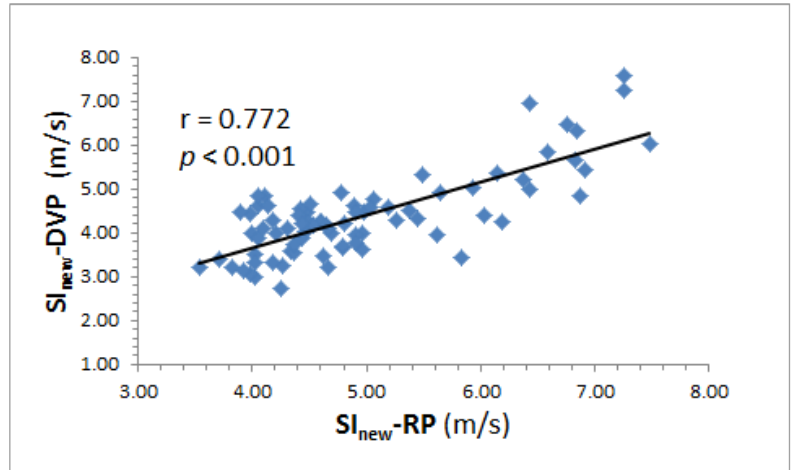
Figure 4. Significant correlation between the SI measured by six-channel ECG-PWV system [7] and SI calculated using the new method based on decomposed radial pulse signals (measured by a refined air pressure sensing system) [15]. SI new -RP—SI calculated using the new method based on decomposed radial pulse signals proposed in Equation (4); SI new -DVP—SI calculated using the new method based on decomposed DVP signals proposed in Equation